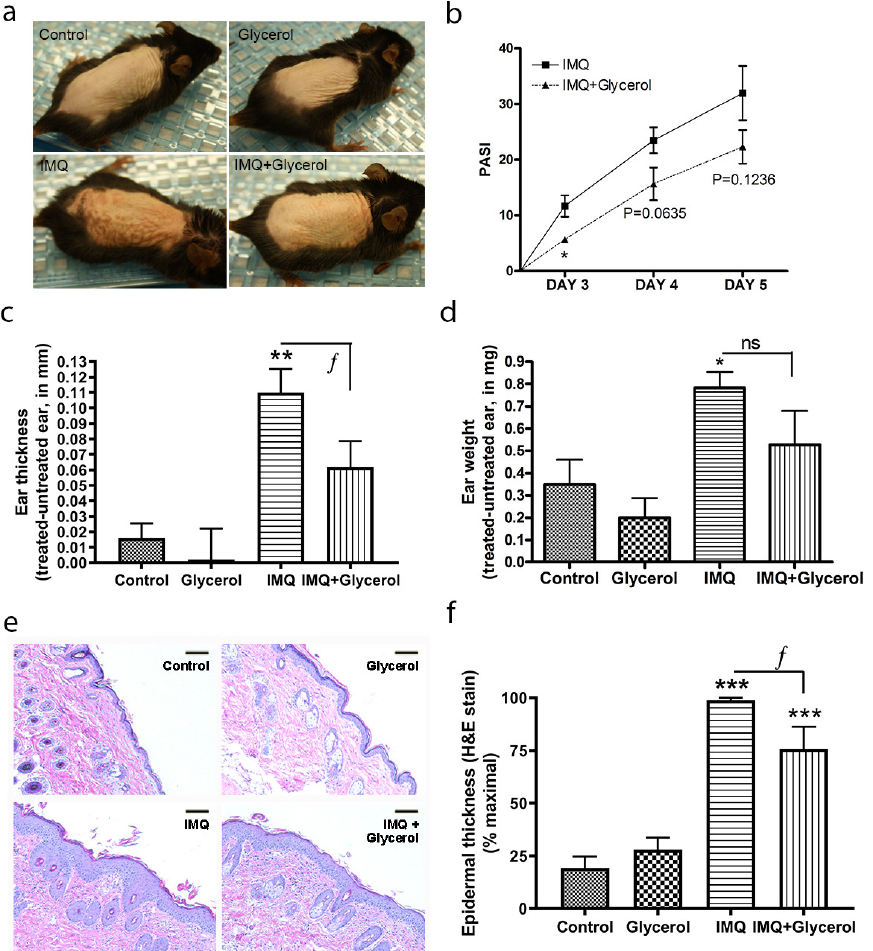
Figure 3. Oral glycerol improved IMQ-induced psoriasiform lesions in wild-type C57BL/6 mice. Mice receiving glycerol (2%) in drinking water or not were treated with vehicle or IMQ daily for 5 days. ( a ) Representative photographs (day 6) showing effects on epidermal erythema and scaling with treatments. ( b ) Psoriasis area severity index (PASI) scores analyzed by unpaired, two-tailed t-test comparing two groups within the same day. ( c ) Ear thickness and ( d ) ear biopsy weight measured as described in Methods. ( e ) Representative H&E-stained micrographs showing back skin epidermal thickening with IMQ treatment (scale bar = 100 µ m). ( f ) Quantitation of the thickness expressed as the percent maximal value, presented as means ± SEM ( n = 4–5). ANOVA with Student–Newman– Keuls multiple-comparison post-hoc tests was used to determine significant differences; * p < 0.05, ** p < 0.01, *** p < 0.001 versus control; ƒ p < 0.05 as